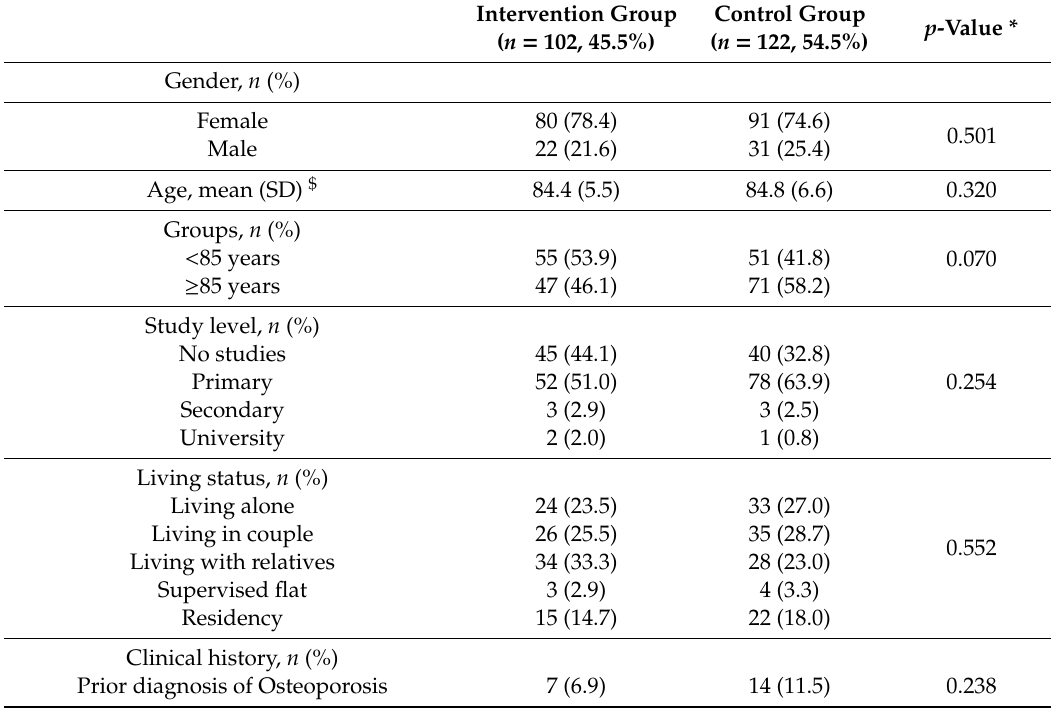
Table 1. Baseline demographic and clinical characteristics of patients. ASA PS, American Society of Anesthesiologists physical state.